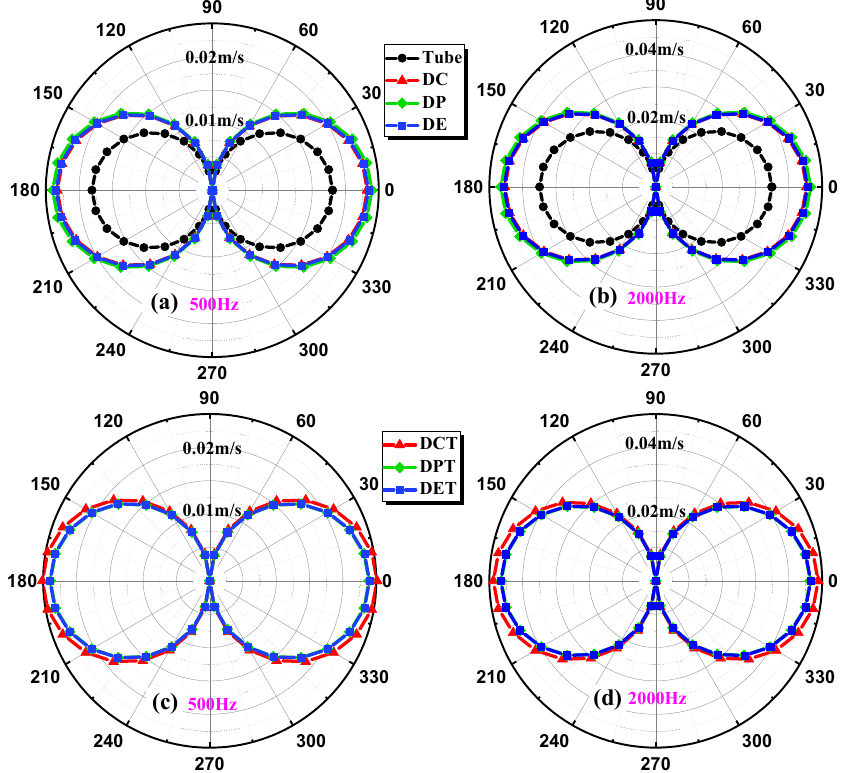
Figure 7. Directivity patterns of different kinds of acoustic horns: ( a ) without middle tube at 500 Hz; ( b ) without middle tube at 2000 Hz; ( c ) with middle tube at 500 Hz; ( d ) with middle tube at 2000 Hz.